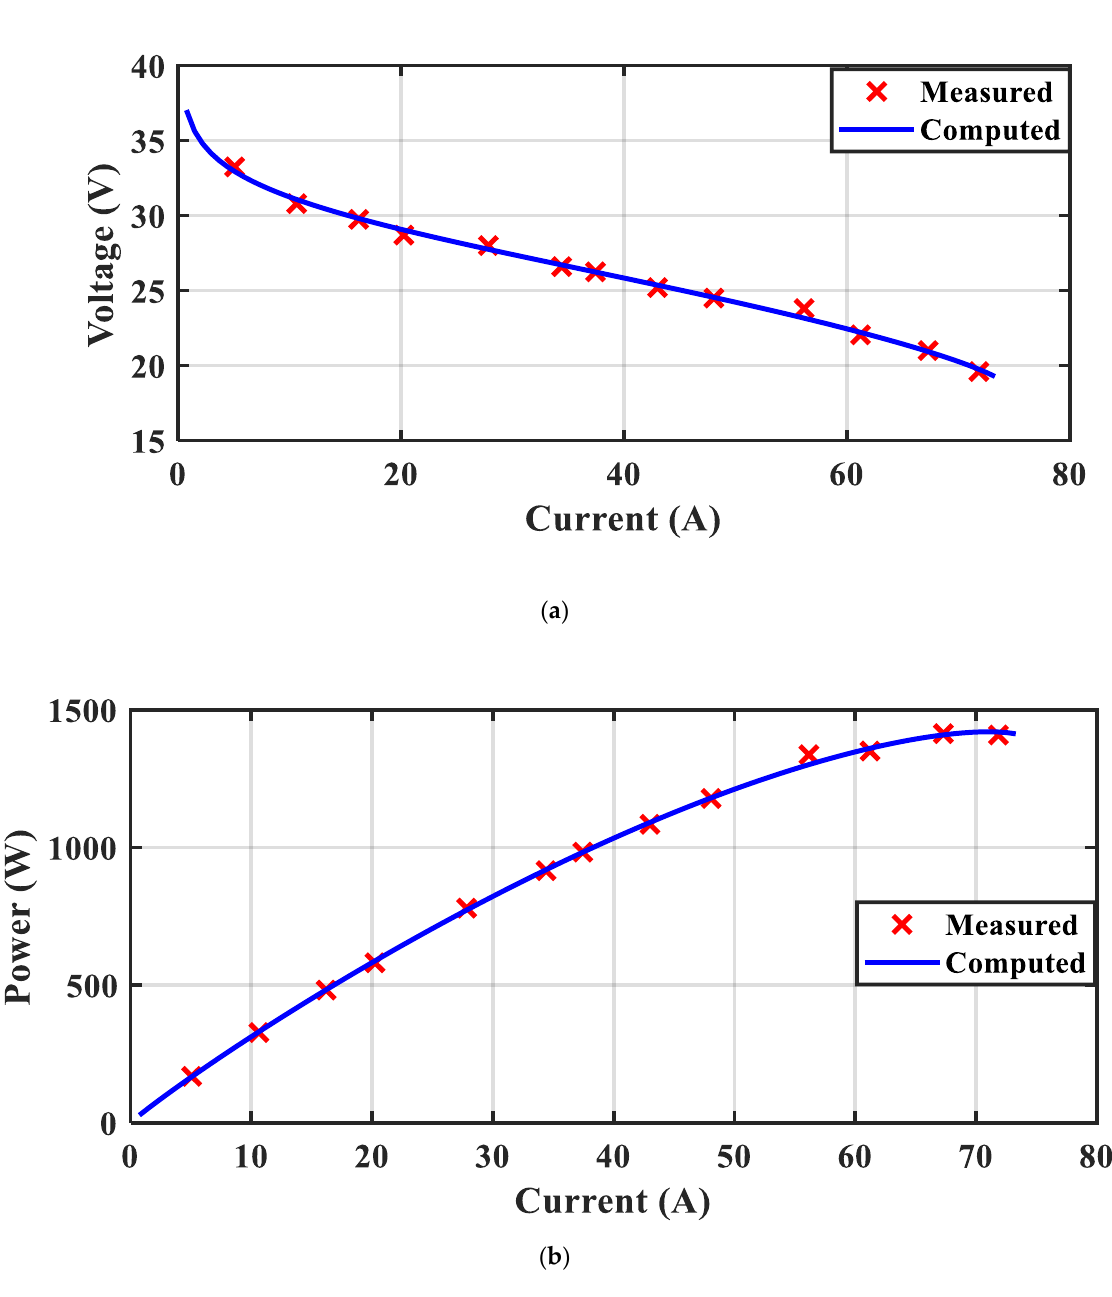
Figure 3. Polarization curves of Ballard fuel cell using the HGS algorithm. ( a ) I – V curves. ( b ) I – P curves.